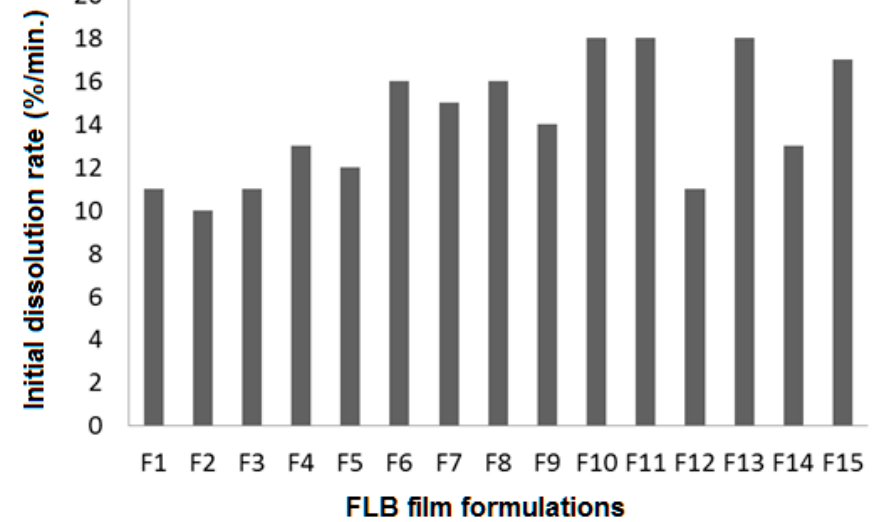
Figure 10. IDR (%) for FLBFDOF formulations.